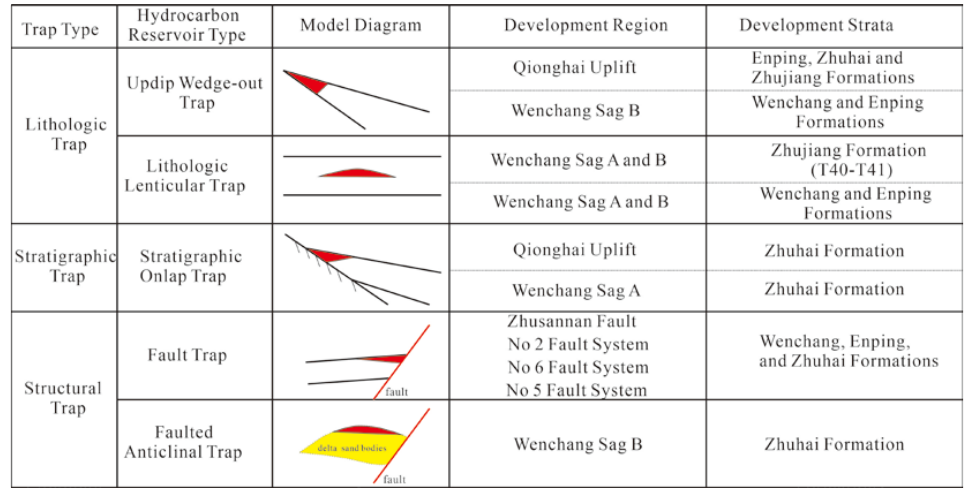
Figure 12. The types of traps and their development strata and regions in the Zhu Ⅲ Depression, PRMB.